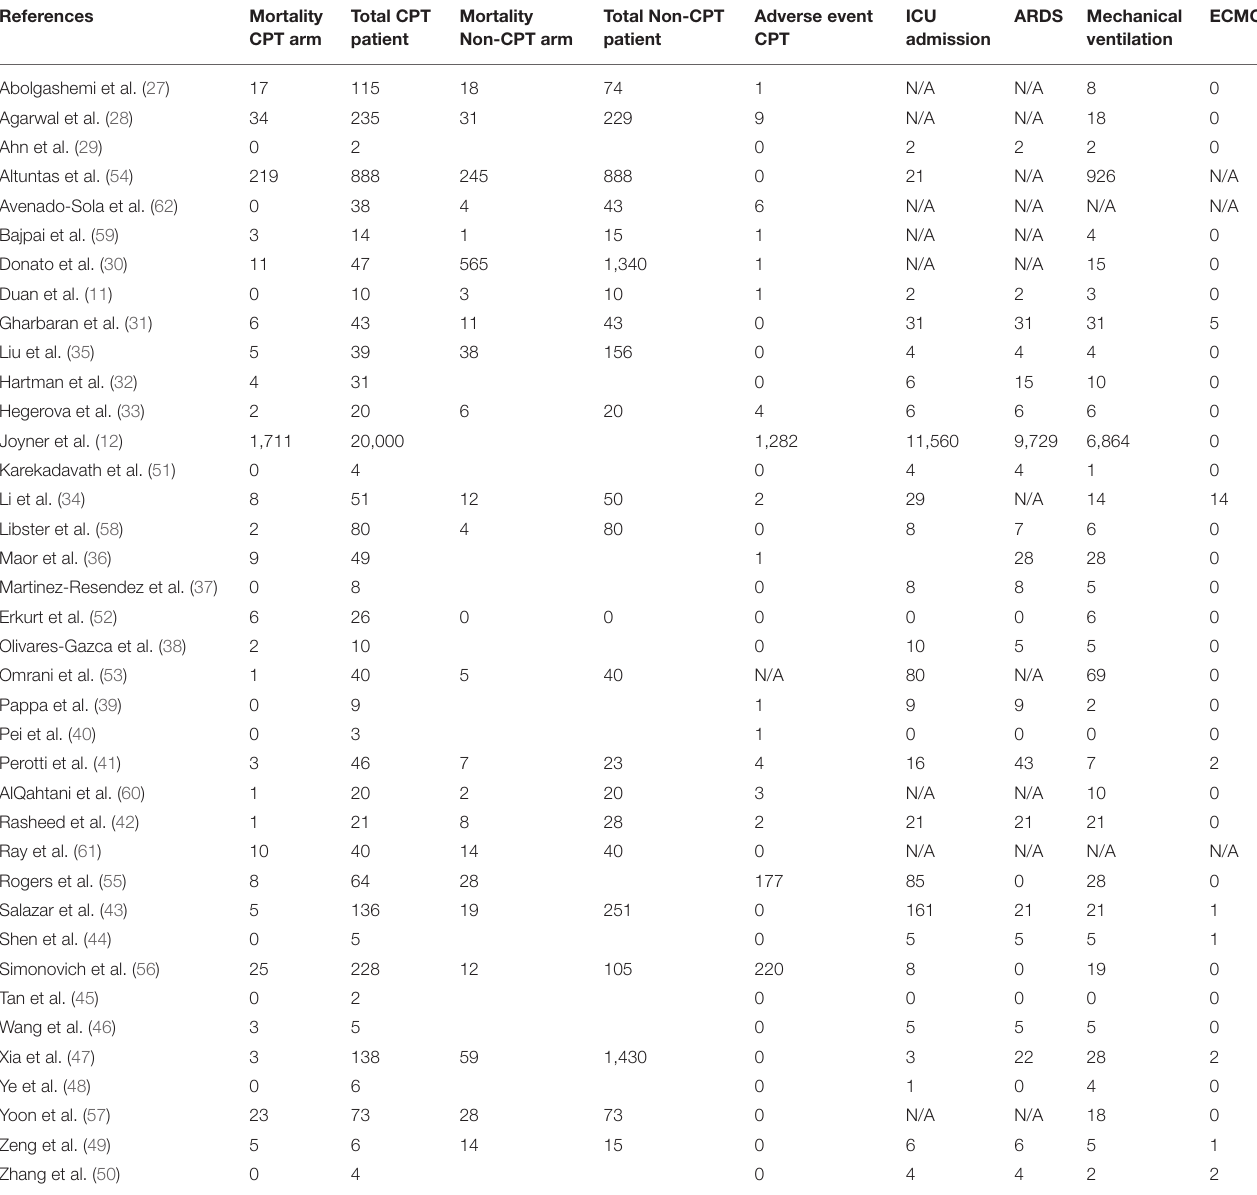
TABLE 1B | Study characteristic